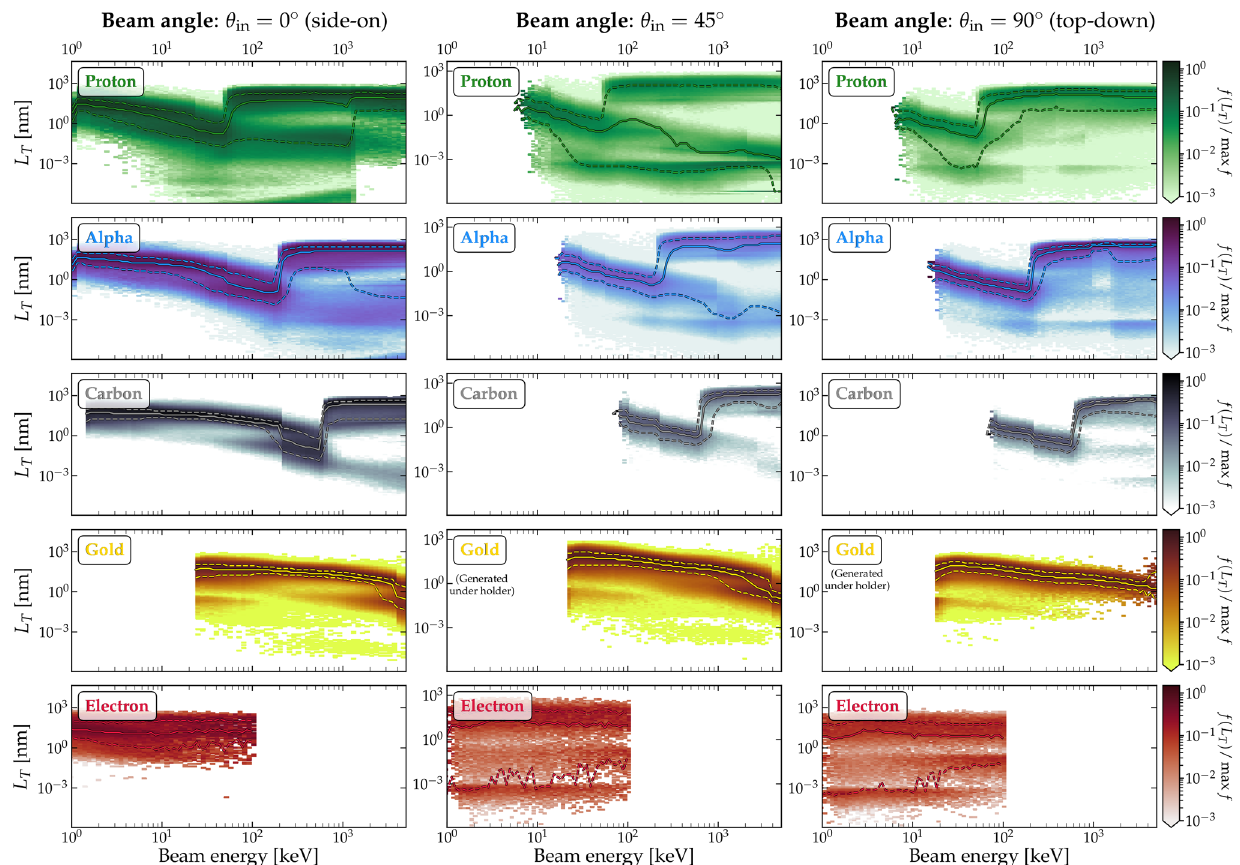
Fig. 8 Distributionsoftransversetrackdimension f ( L T ) asafunction of incident beam energy for different incident beam angles. The colour- scale shows the value of the distribution, normalised by its maximum value at each energy. The four panels from top to bottom correspond to different incident particles: protons, alphas, carbon nuclei, gold nuclei, and electrons. Results are shown for gold nuclei in the θ in = 0 ◦ case for